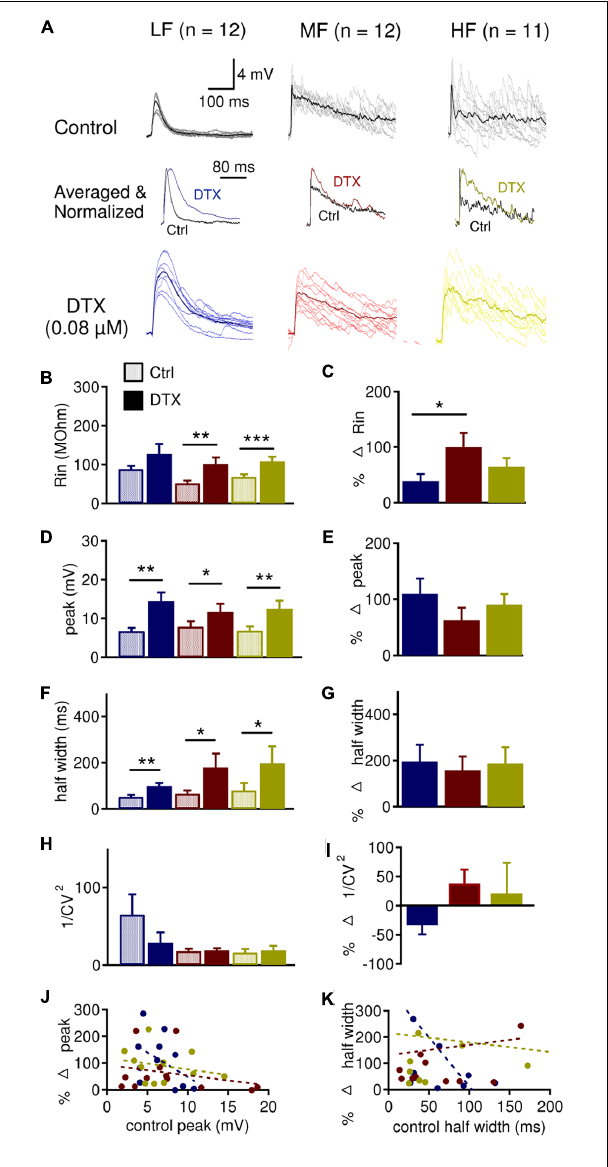
FIGURE 6 | LTK currents regulate evoked IPSP size in the NL. (A) Sample IPSP recordings before (dark traces) and after (color traces) bath application of DXT (0.08 μ M), in LF ( n = 12), MF ( n = 12) and HF ( n = 11) NL neurons. QX-314 (5 mM) was present in the intracellular solution. Above and below are raw (gray or light color) and averaged (black or dark color) IPSP recordings. Normalized averaged IPSP recordings before (black) and after (color) dendrotoxin I (DTX) are shown in the center. (B) DTX significantly increased the input resistance (R in ) in MF (control: 51.6 ± 6.5 M (cid:2) , DTX: 101.2 ± 16.9 M (cid:2) ), and HF (control: 68.6 ± 6.8 M (cid:2) , DTX: 108.1 ± 12.0 M (cid:2) ) neurons but not in LF (control: 88.4 ± 8.2 M (cid:2) , DTX: 126.6 ± 26.5 M (cid:2) ) neurons. (C) R in was increased significantly more in MF (99.8 ± 25.6%) compared to LF (38.3 ± 13.2%) neurons, while HF (64.2 ± 15.8%) did not differ from LF or MF neurons. (D) DTX significantly increased the peak IPSP amplitude in LF (control: 6.7 ± 0.8 mV, DTX: 14.5 ± 2.1 mV), MF (control 7.8 ± 1.4 mV, DTX: 11.7 ± 2.1 mV), and HF (control: 6.8 ± 1.1 mV, DTX: 12.5 ± 2.1 mV) neurons. (E) No tonotopic differences in the effect of DTX on peak IPSP amplitude were observed. (F) DTX significantly increased the half width of IPSP in LF (control: 50.9 ± 9.6 ms, DTX: 97.6 ± 14.8 ms), MF (control: 66.2 ± 13.0 ms,